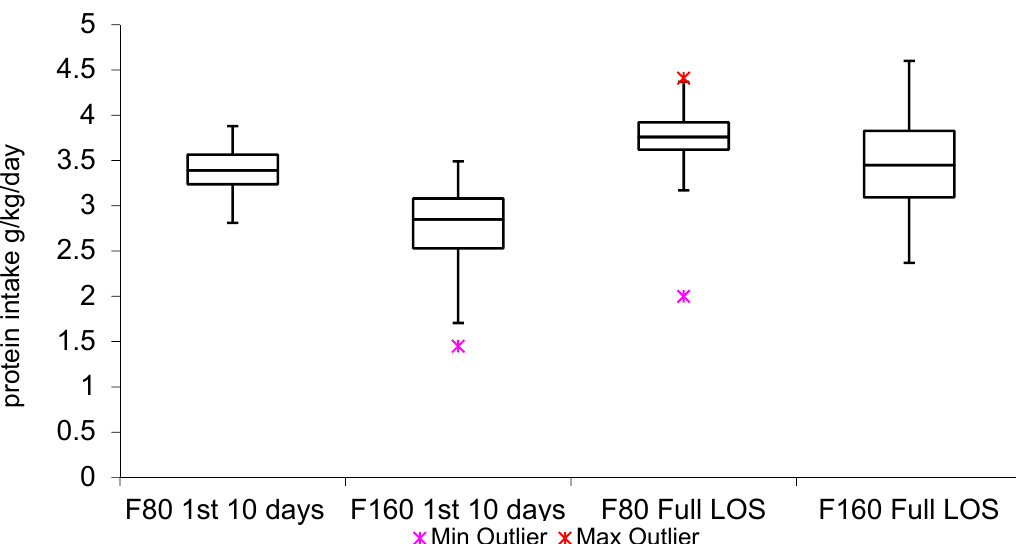
Figure 1. Box plot of protein intake for the F80 and F160 groups during the first 10 days of feeding and for the F80 and F160 groups over the full LOS. Daily protein intake for the first 10 days—Median (F80: 3.89, F160: 2.85). Daily protein intake for the first 10 days—IQR (F80: 0.33, F160: 0.55). Protein Intake daily per full LOS—Median (F80: 3.76, F160: 3.45). Protein Intake daily per full LOS—IQR (F80: 0.30; F160: 0.75), LOS, length of stay. 1st, first. IQR, inter quartile range.